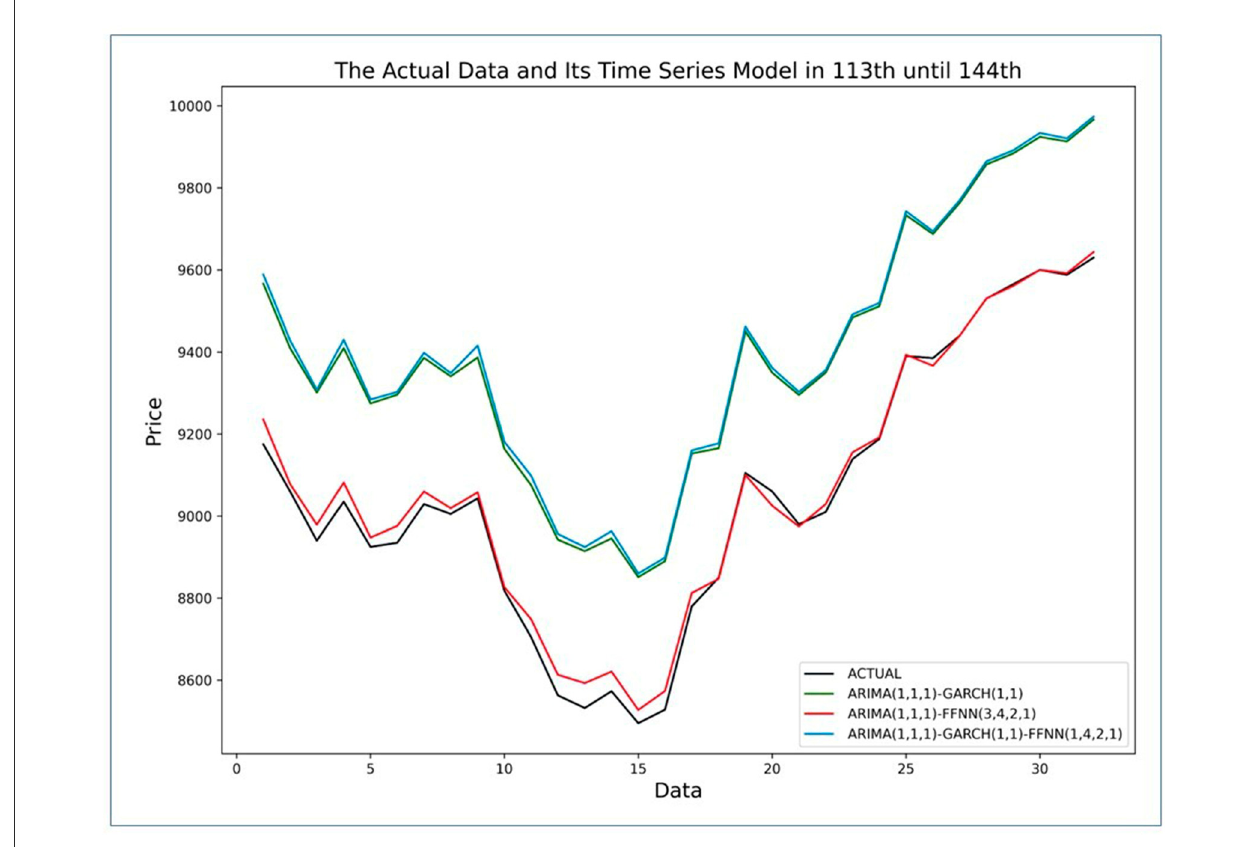
FIGURE10 Comparison of 113th until 144th actual currency exchange rate against predicted values of ARIMA with GARCH, FFNN, and combination of GARCH and